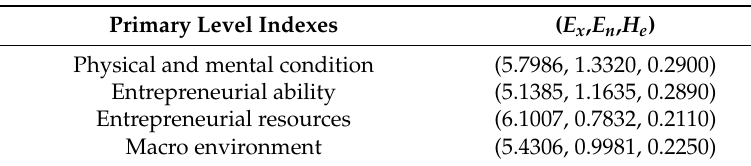
Table 6. The CM of primary level